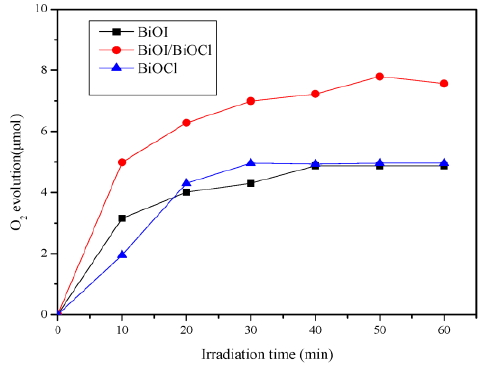
Figure 11. The photocatalytic O 2 evolution of BiOI, BiOCl, and BiOI/BiOCl composites.